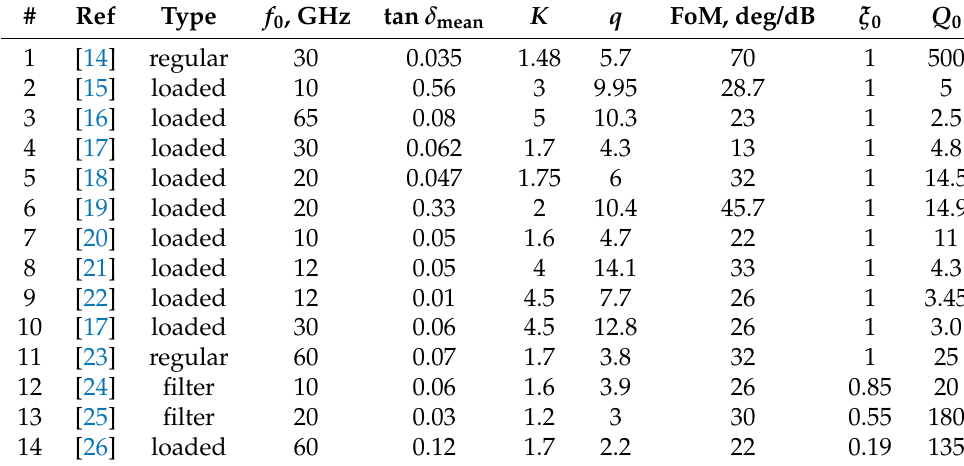
Table 1. Experimental parameters of phase-shifters